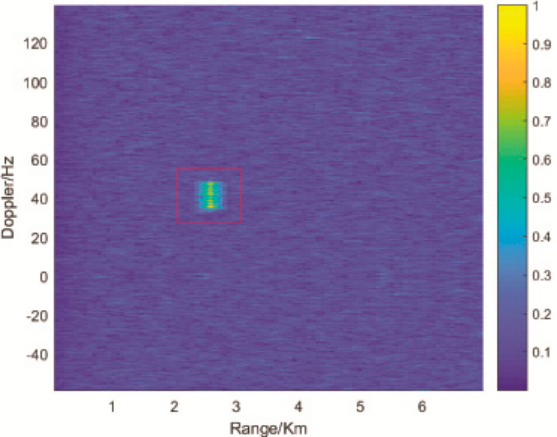
Figure 5. RD map based on FT with clutter cancellation. Subsequently, the long time integration method that is based on modified radon Fourier transform (MFRT) is applied as comparison. Figure 6 shows the RD map obtained by MFRT. When compared with the RD map in Figure 5, it can be seen that the Doppler spread has been effectively eliminated. However, a slight spread is still existing in Doppler dimension. It can be deduced that the spread is caused by the parameter estimation error.